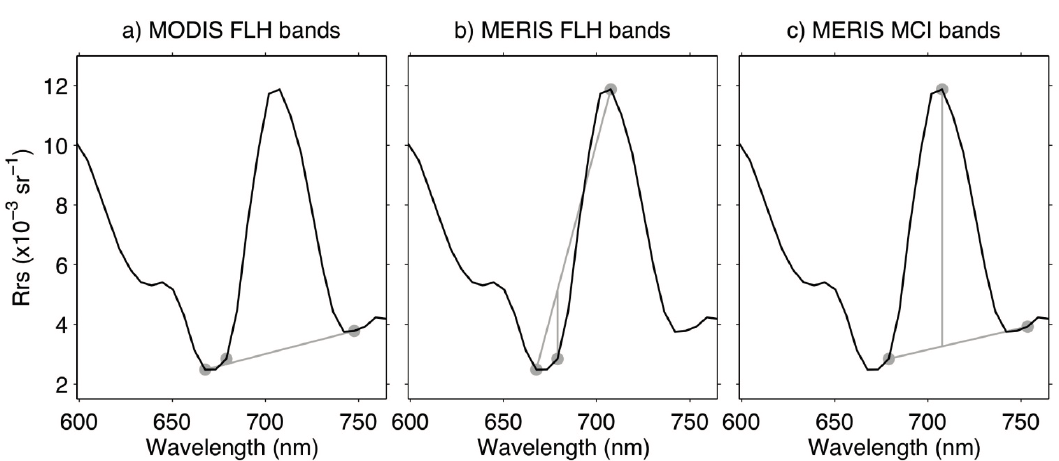
Figure 12. Linear baseline algorithm (LBA) performance relative to the intense bloom spectrum from the 6 November 2012 HICO image (Figure 11). The spectrum is an average computed from pixels exhibiting a peak in the HICO 708 nm band. Band centers (gray circles) for each algorithm are the HICO band center wavelengths listed in Table